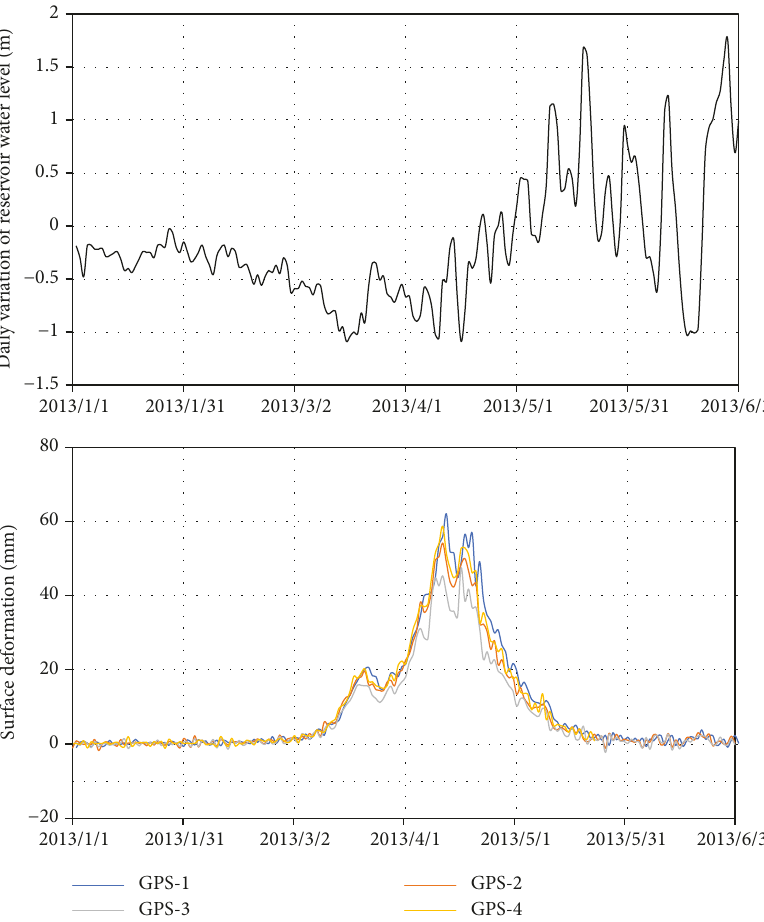
Figure 12: The magnitude of daily drawdown of reservoir water level from January to June 2013 versus surface deformation measured by